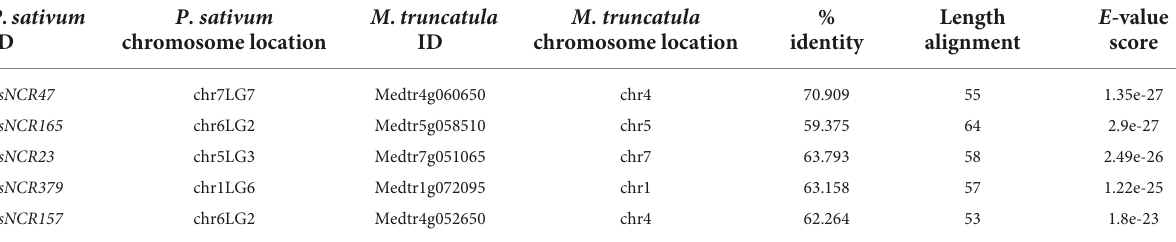
TABLE 1 List of five P. sativum NCRs that are most similar to M. truncatula